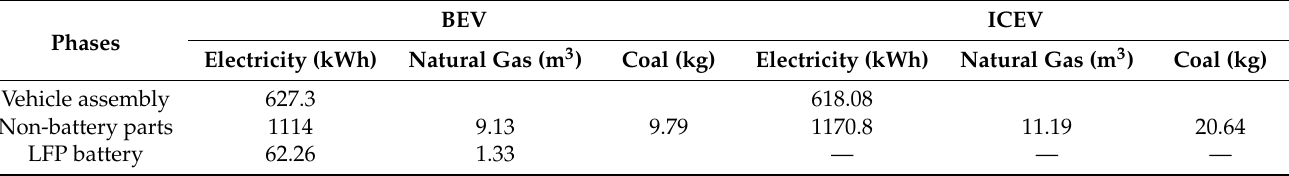
Table A8. Energy consumption of the vehicle recycling